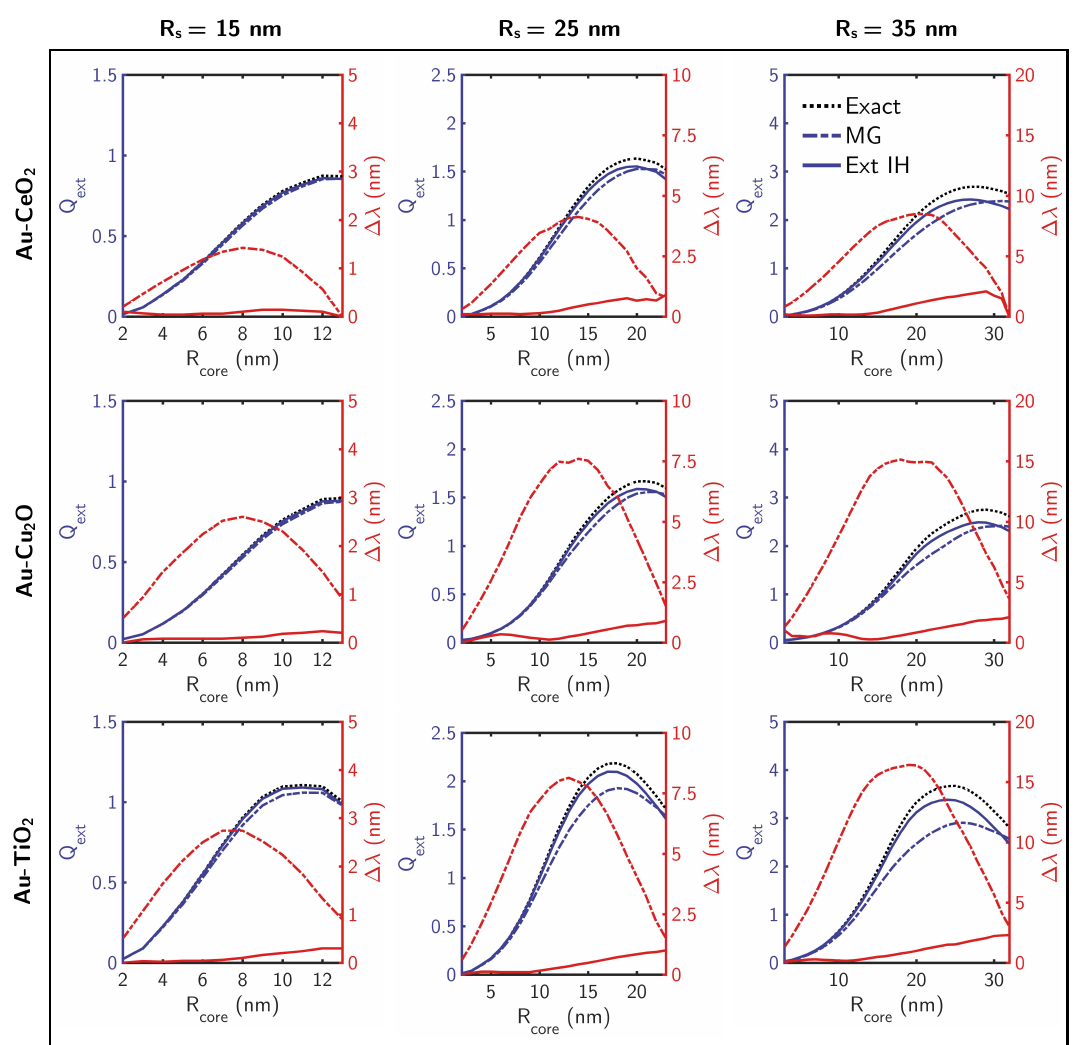
Figure 7. Value of the Q ext peak (left blue axis) predicted by MG and Ext. IH, and their comparison with the exact solution. Spectral shift ( ∆ λ , red right axis) of the Q ext peak predicted through MG and Ext. IH effective medium theories (EMTs) with respect to the exact solution as a function of the core radius R c . The nanoparticles considered are Au-CeO 2 (top row), Au-Cu 2 O (middle row) and Au-TiO 2 (bottom row) core-shells of total radius R s and different core sizes: R s = 15 nm (first column), R s = 25 nm (middle column) and R s = 35 nm (right